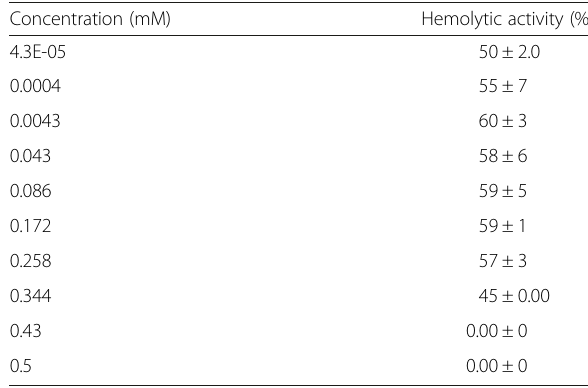
Table 2 Effects of divalent cations on the hemolytic activity of M. alcicornis aqueous extract tested at the HU Table 3 Effect of EDTA on the hemolytic activity of the 50 M. alcicornis aqueous extract tested at the HU Concentration (mM) Hemolytic activity (%) Ca 2+ Mg 2+